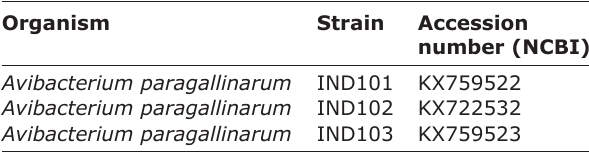
Table-1: NCBI accession number assigned to 16S rRNA sequences of Indian field isolates of Avibacterium paragallinarum.